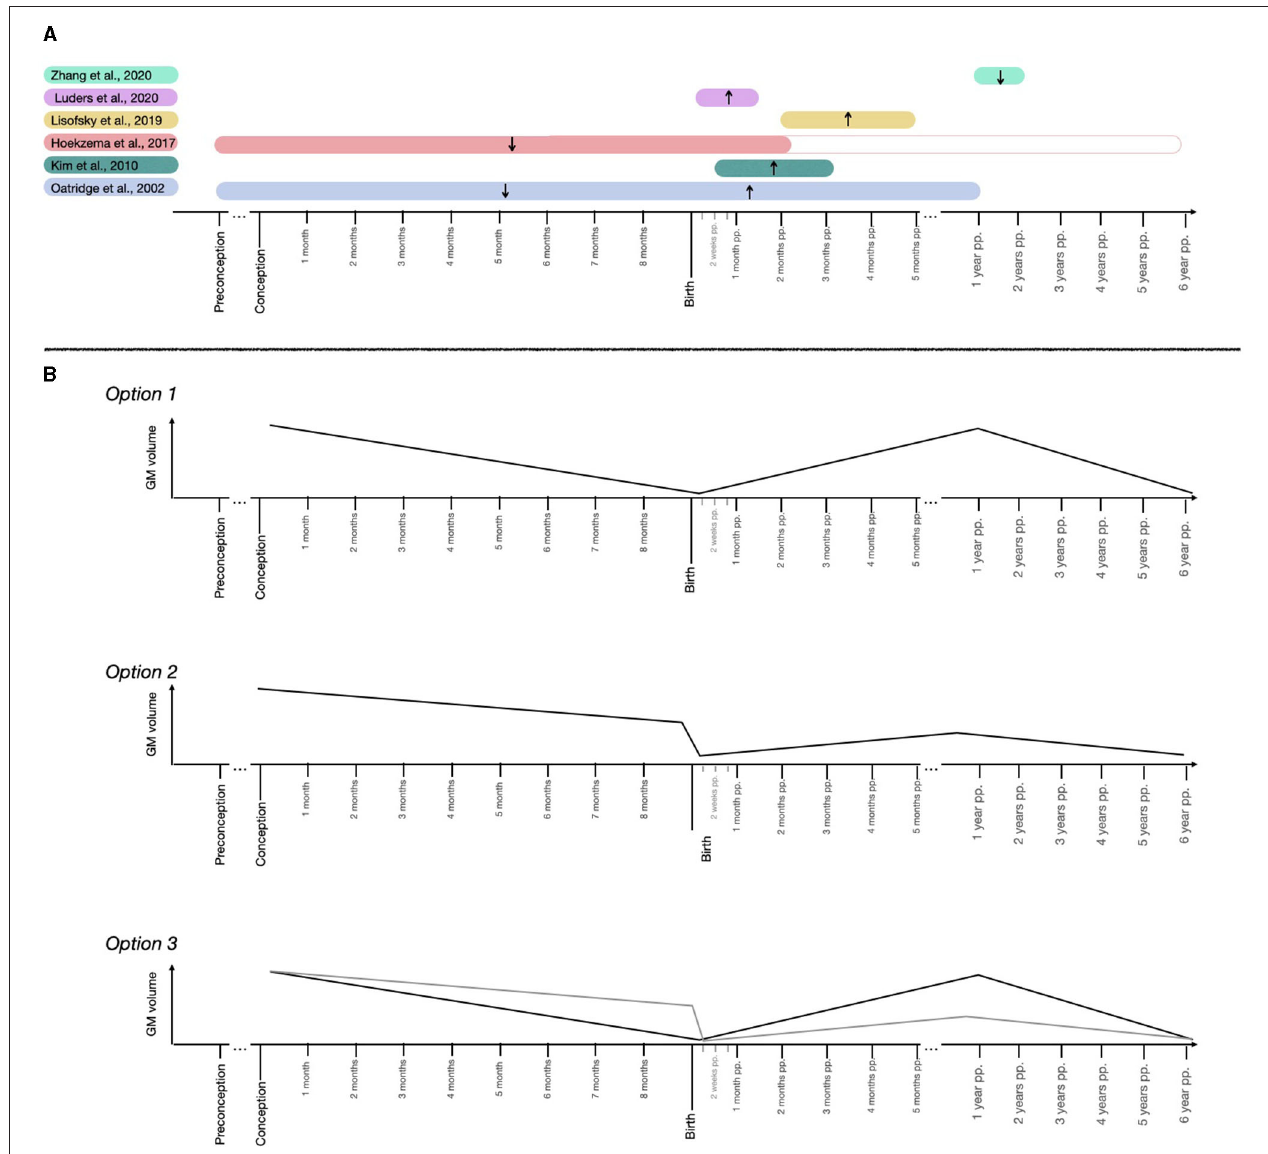
FIGURE 1 | Schematic representation of the maternal brain GM volume findings and suggested trajectories. (A) Findings of the longitudinal MRI structural studies tracking the maternal brain. Represented studies are (2–7). (B) Hypothetical trajectories in GM volume across pregnancy and postpartum